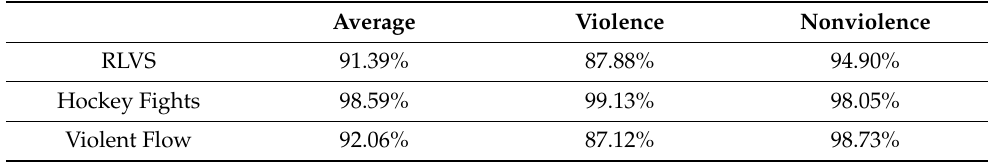
Table 6. Video frame recognition